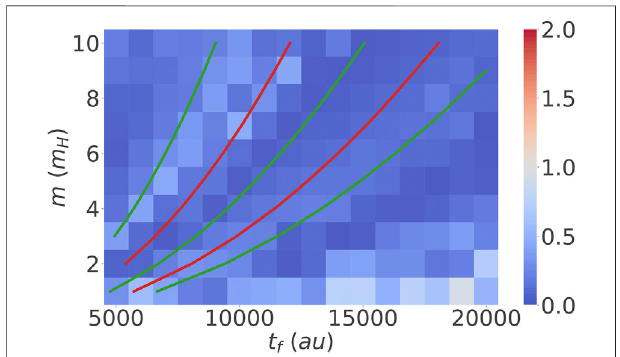
FIGURE7| Erroraccordingto Eq.31 asafunctionofdifferent fi naltimes and masses. Running cost according to Eq. 32 has been used together with Eq. 18 . The penalty scaling factor was η (cid:1) 0 . 003, except for a few cases where lower or higher values has been used, ranging from 0.001 to